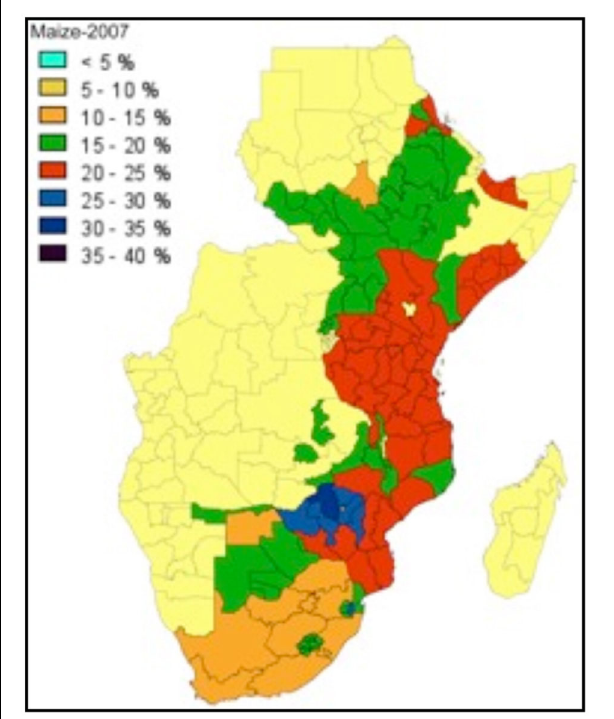
FIGURE 2 | 2011 World Bank Report on post-harvest losses of maize in East Africa.